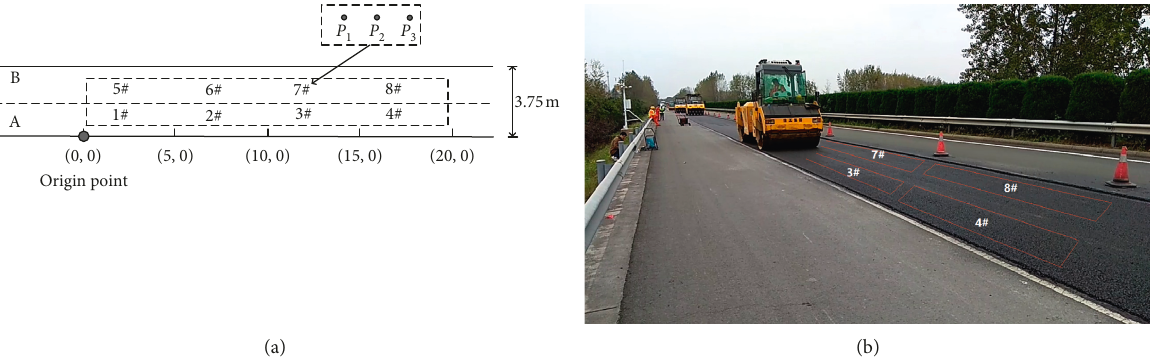
Figure 5: Diagram and scene of field rolling experiments. (a) Diagram of in situ rolling experiments. (b) Scene of in situ rolling